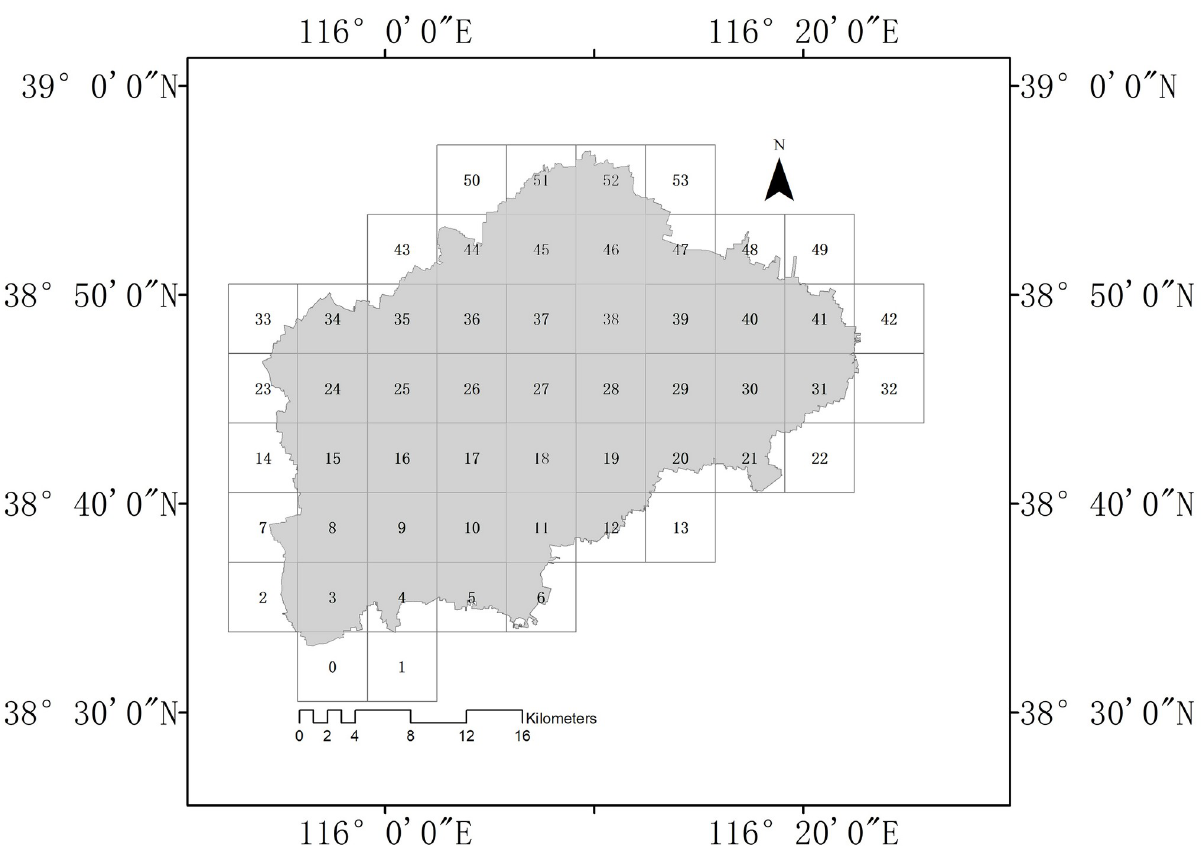
Fig 3. Grid-based division of Renqiu City into 53 individual